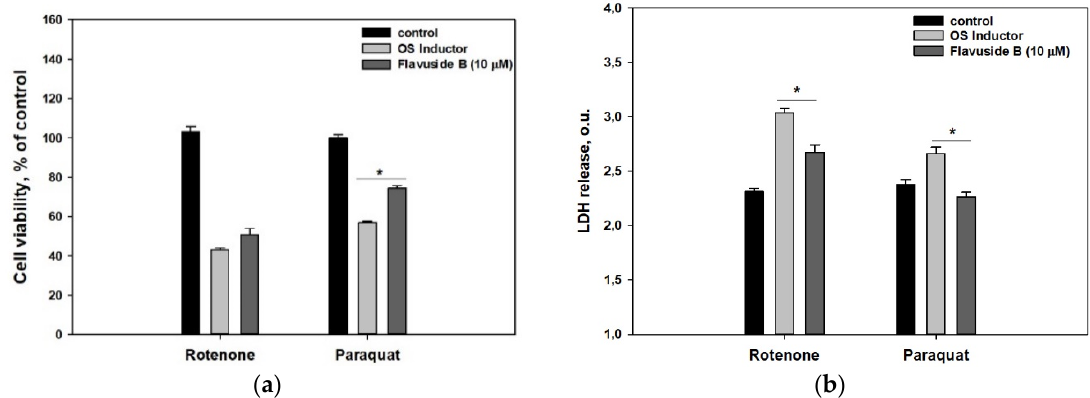
Figure 3. Influence of flavuside B ( 4 ) on the viability estimated using MTT assay ( a ) and LDH release ( b ) in Neuro-2a cells treated with OS inductors, rotenone, and paraquat. Data are presented as mean ± SEM. * indicates significant differences ( p ≤ 0.05). Differences between control and rotenone or paraquat were significant.